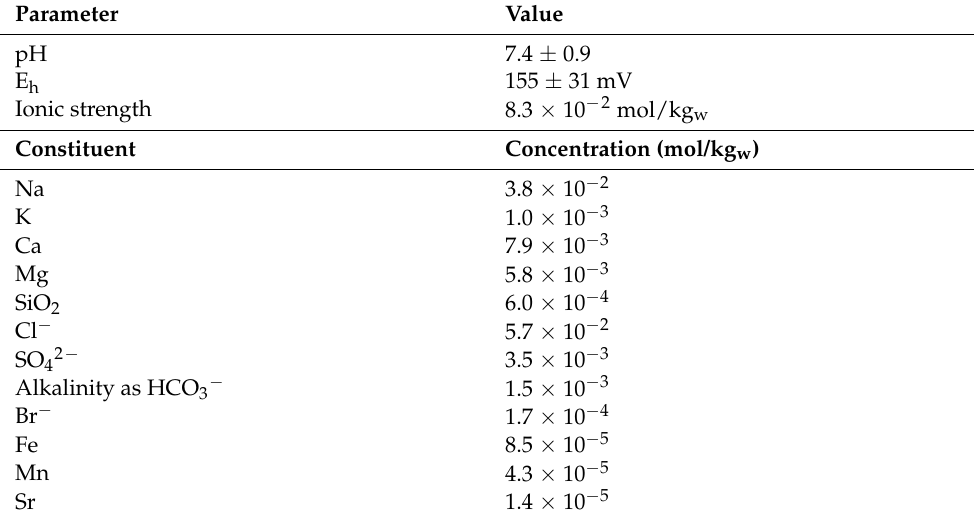
Table 2. Geochemical parameters of the natural groundwater system employed in this work.